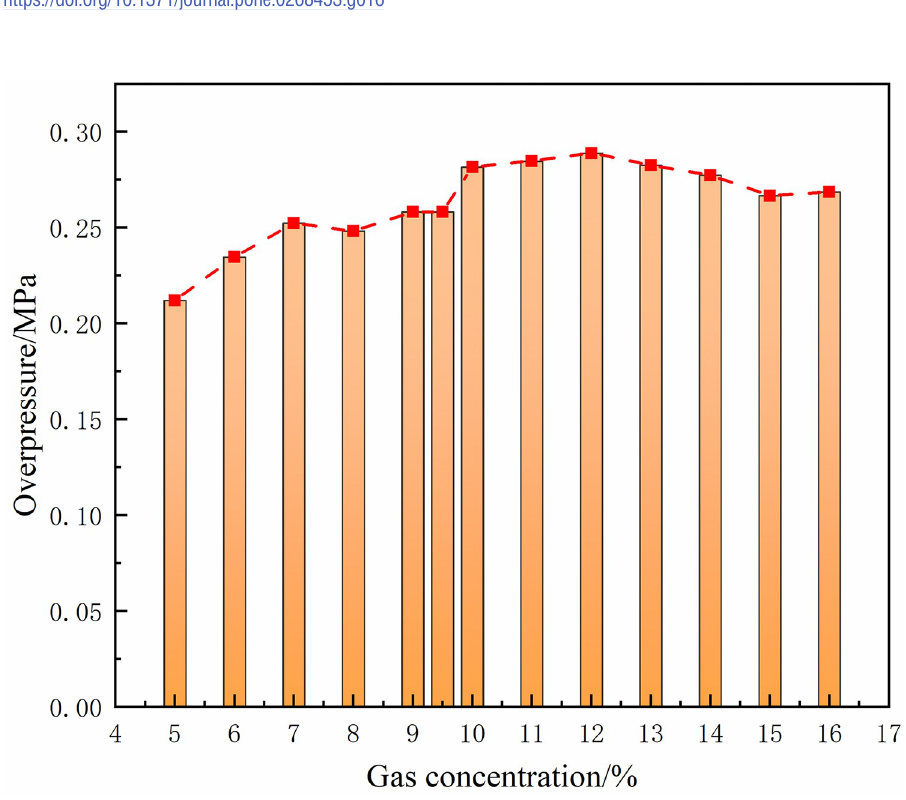
Fig 17. Pressure—Time curves and peak at monitoring point 7 at different gas concentrations (pressure peak).